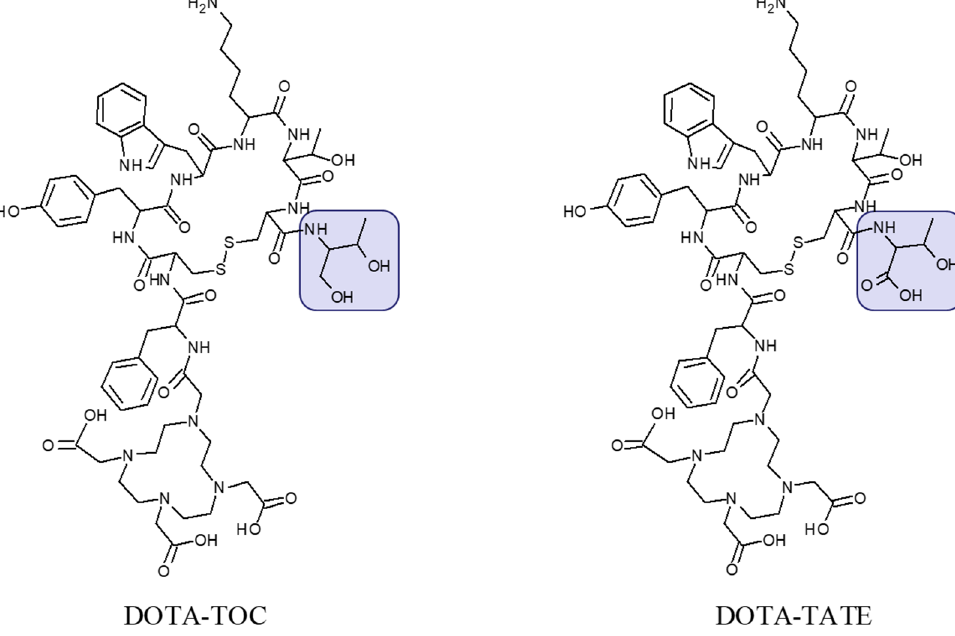
Figure 2. Chemical structure of DOTA-Tyr3-octreotide (DOTA-TOC) and DOTA-(Tyr3, Thr8)-octreotate (DOTA-TATE) presenting difference in C-terminal where the carboxyl group in threonine amino acid residue (DOTA-TATE) is exchanged to hydroxyl group (DOTA-TOC).